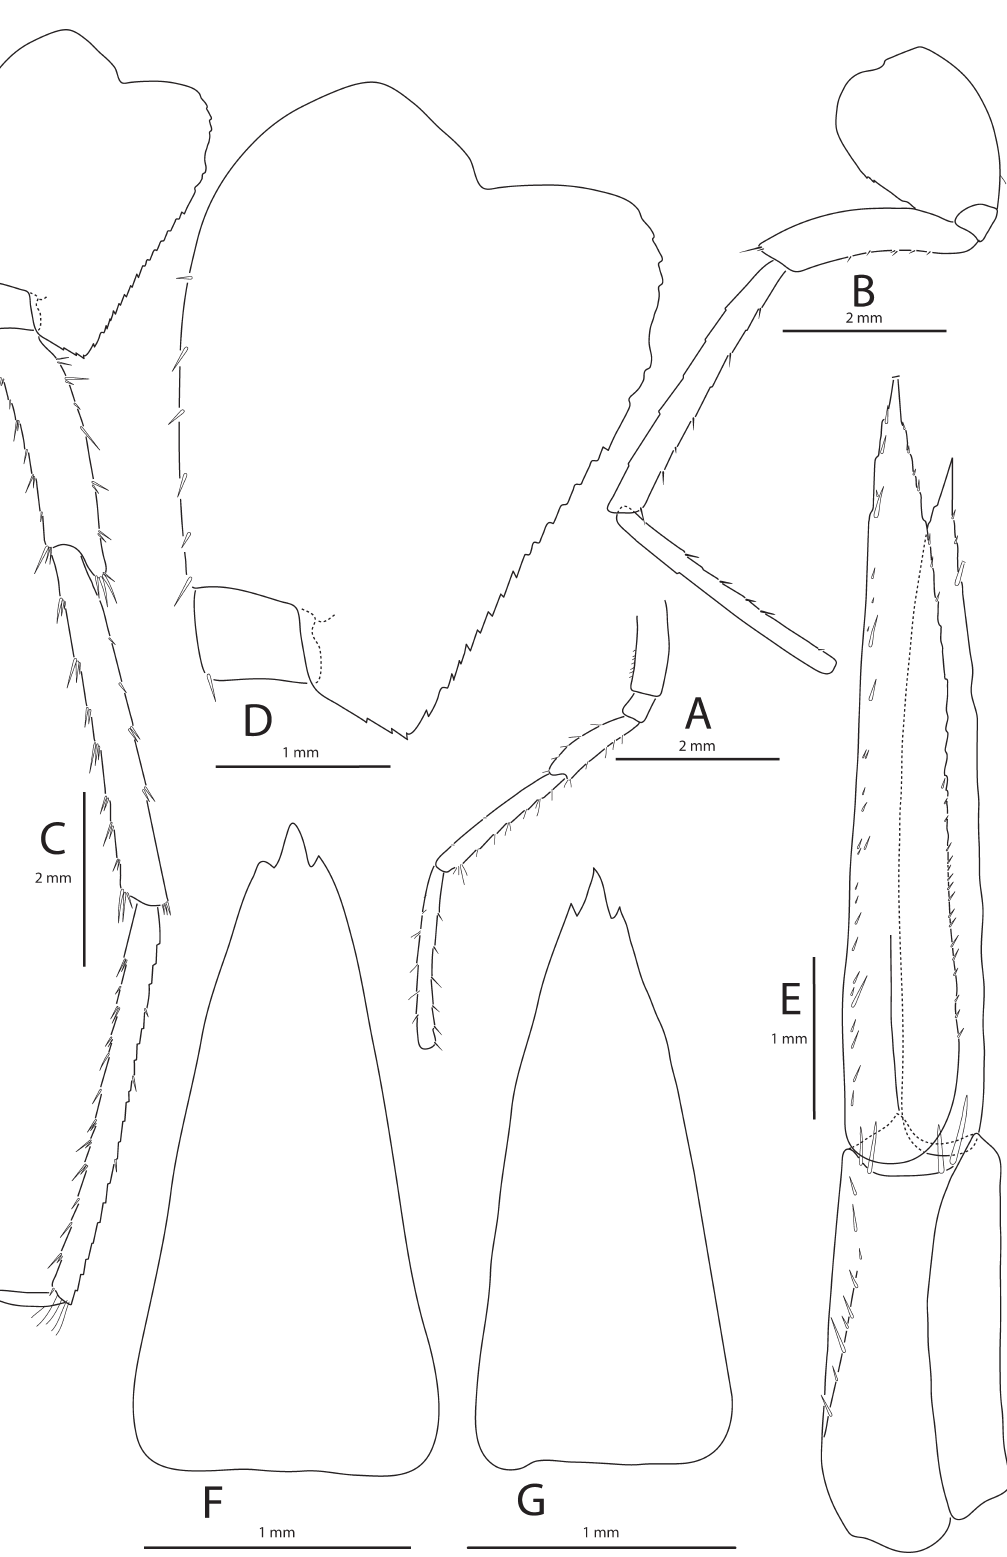
Fig. 9. Halirages qvadridentatus G.O. Sars, 1877 (syntypes of Halirages elegans Norman, 1882), Faeroe Islands, RV Knight Errant , stn 8, microscopical preparations by Norman. A . left P4. B . right P6. C . left P7. D . basis and ischium of left P7 (proximal part of posterior border eroded). E . left U3. F-G .